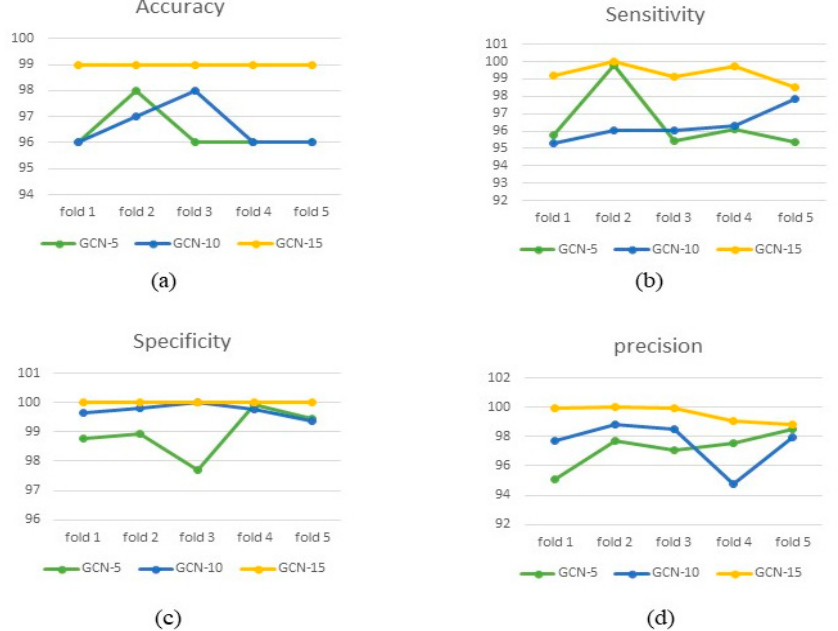
Figure 5. The performance values (including Accuracy, Sensitivity, Specificity and Precision) for GCN-MI-5, GCN-MI-10, and GCN-MI-15 using various k-fold CVs, are illustrated in subfigures ( a – d ), respectively.